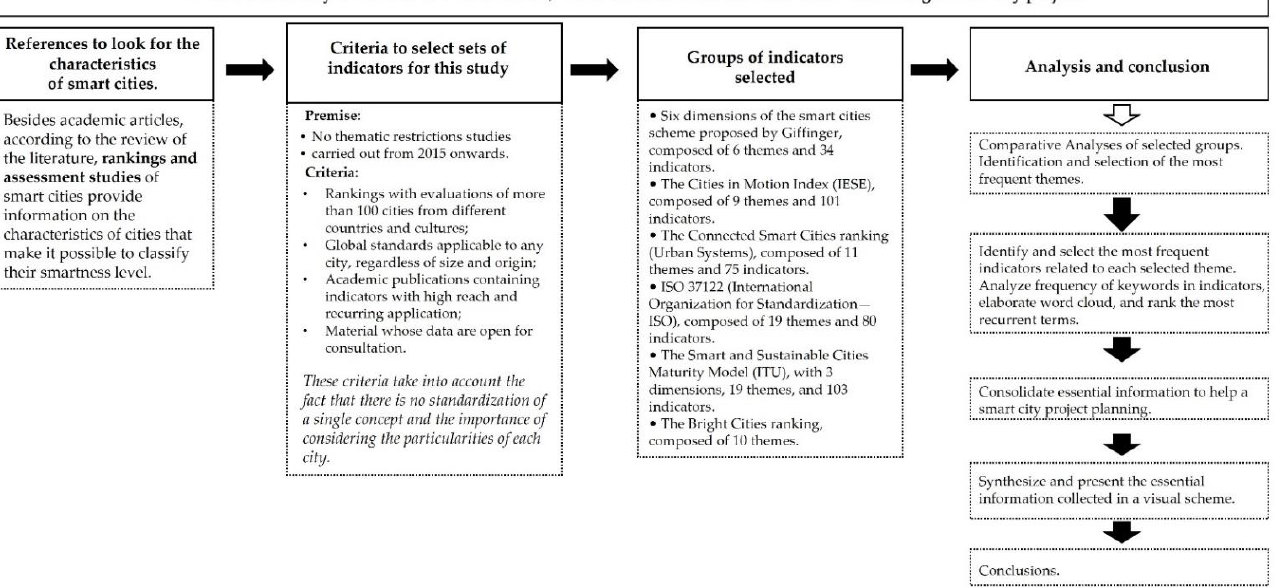
Figure 6. Study flowchart.